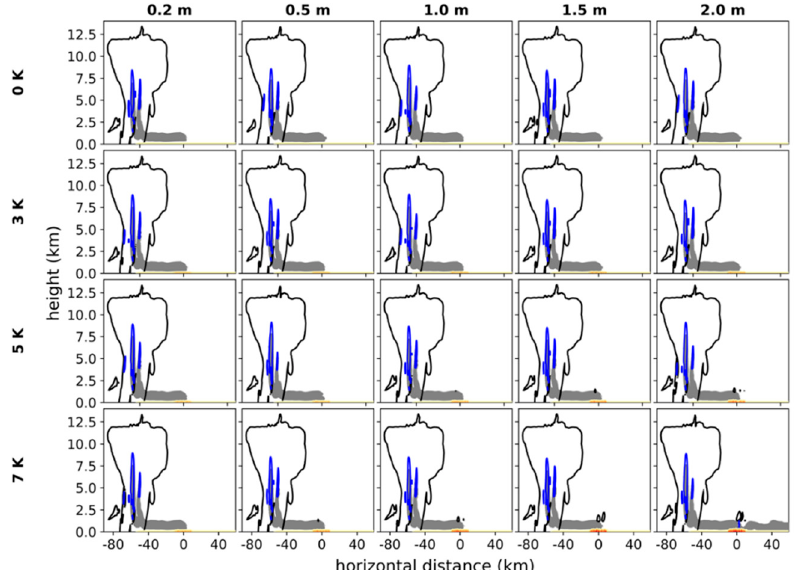
Figure 20. Evolution of parcel trajectories entering the storm updraft. The gray lines indicate parcel positions from the start of the simulation through 100 min, the solid black contour represents the hydrometeor mixing ratio of 0.02 g kg − 1 at t = 100 min, and the blue line is the 5 m s − 1 contour of vertical velocity at t = 100 min. Temperature at t = 100 min is contoured from 299 K (yellow) to 305 K (red) with a spacing of 0.5 K.